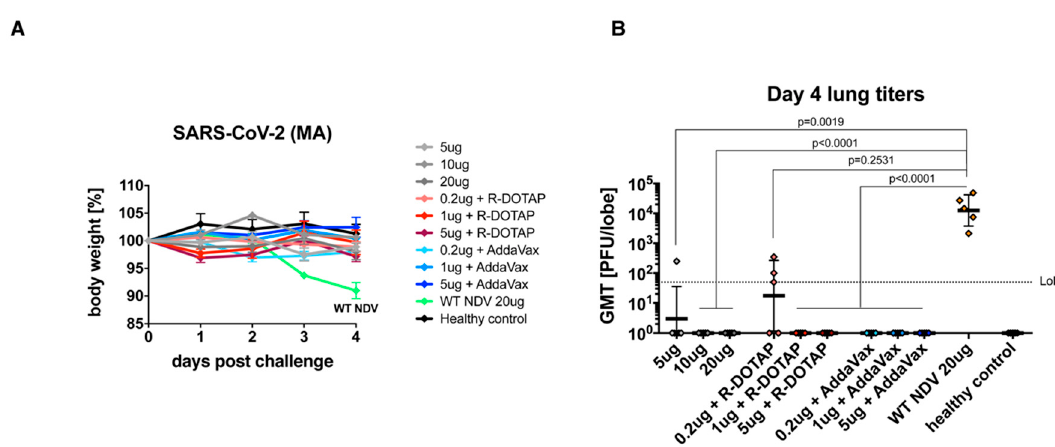
Figure 4. Inactivated NDV-S vaccine protects mice from SARS-CoV-2 infection. ( A ) Weight loss of mice infected with SARS-CoV-2. Weight loss of mice challenged with a mouse-adapted SARS-CoV-2 strain was monitored for 4 days. ( B ) Viral titers in the lung. Lungs of mice were harvested at day 4 post-infection. Viral titers of the lung homogenates were determined by a plaque assay. Geometric mean titer (PFU / lobe) is shown (LoD: limit of detection). Statistical analysis was performed using the Kruskal–Wallis test with Dunn’s correction for multiple comparisons. P-values between groups were shown.